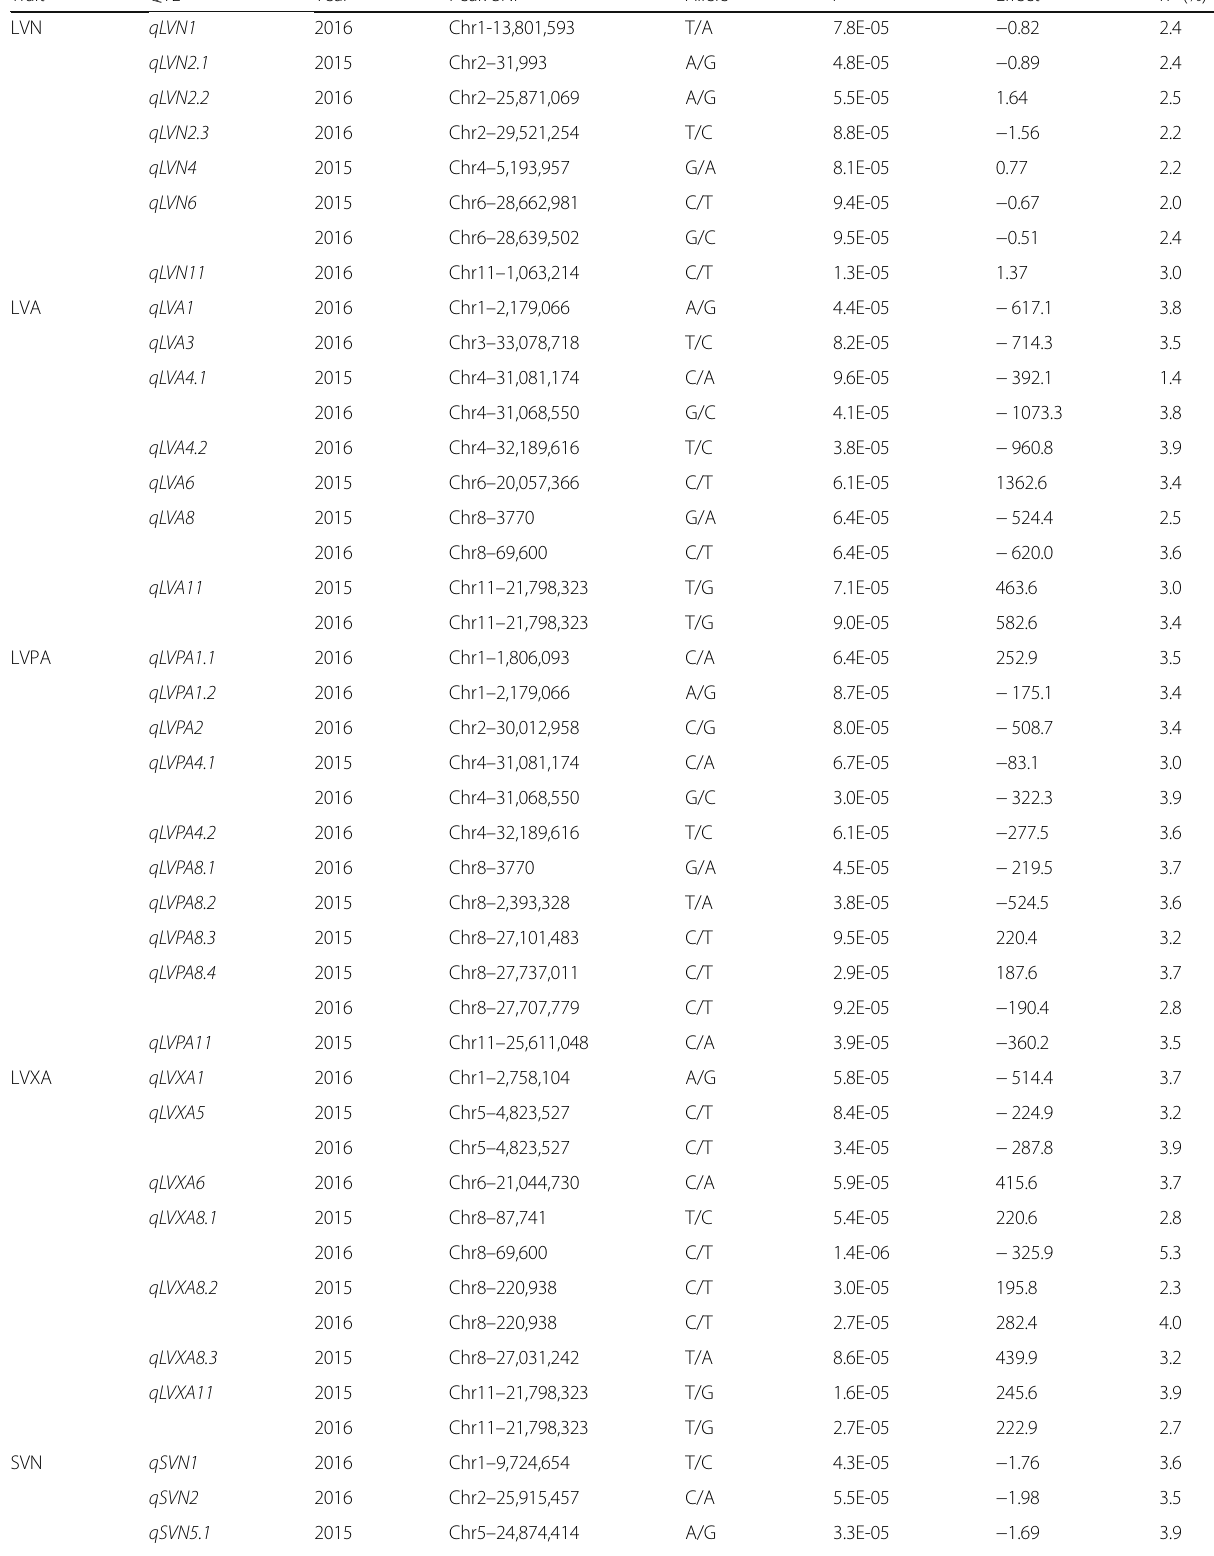
Table 1 QTL identified for eight peduncle vascular bundle related traits in two years Trait